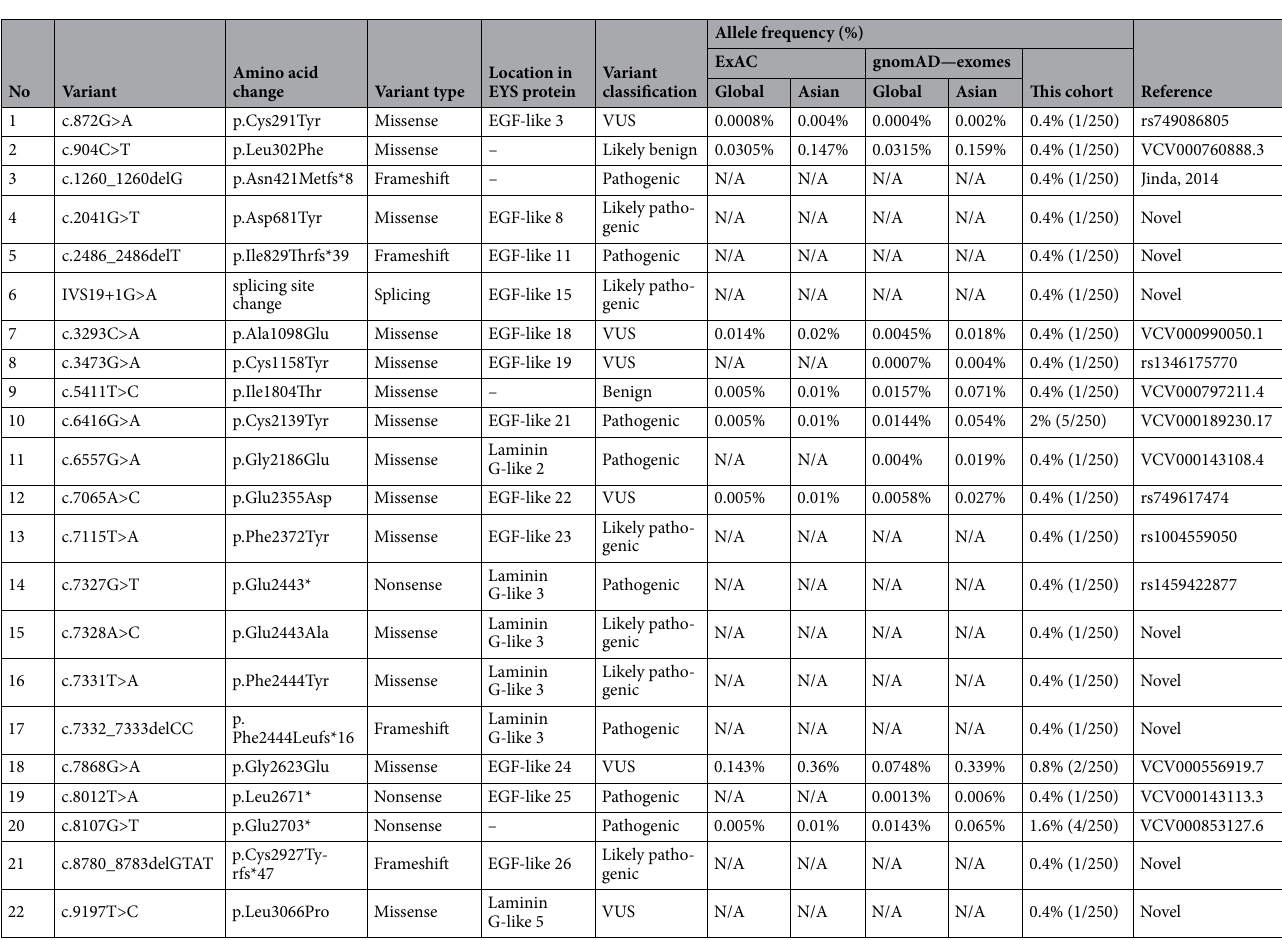
Table 1. Variants of the EYS gene. EGF-like domain, epidermal growth factor-like domain; VUS, variant of unknown significance; ExAC, Exome Aggregation Consortium; gnomAD, Genome Aggregation